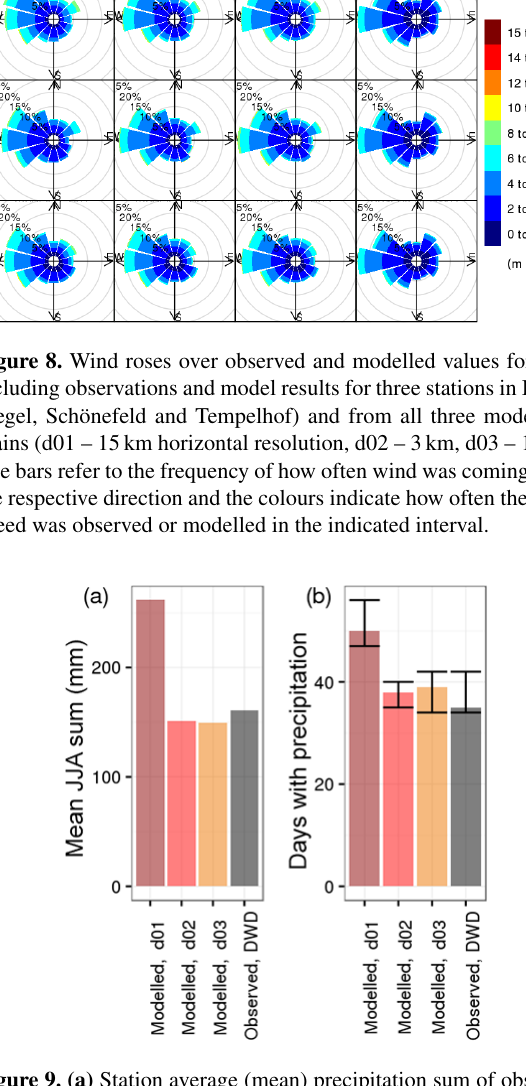
Figure 9. (a) Station average (mean) precipitation sum of observa- tions and model results (base run), (b) median number of days with precipitation observed or modelled. A day is counted if observed or modelled precipitation was more than 1mmh − 1 . Ranges indicate the variability between the different stations. Both panels (a) and (b) show averages over nine stations and the corresponding model grid cells in Berlin and its surroundings. Model results are given for all three model domains (d01 – 15km horizontal resolution, d02 – 3km, d03 –